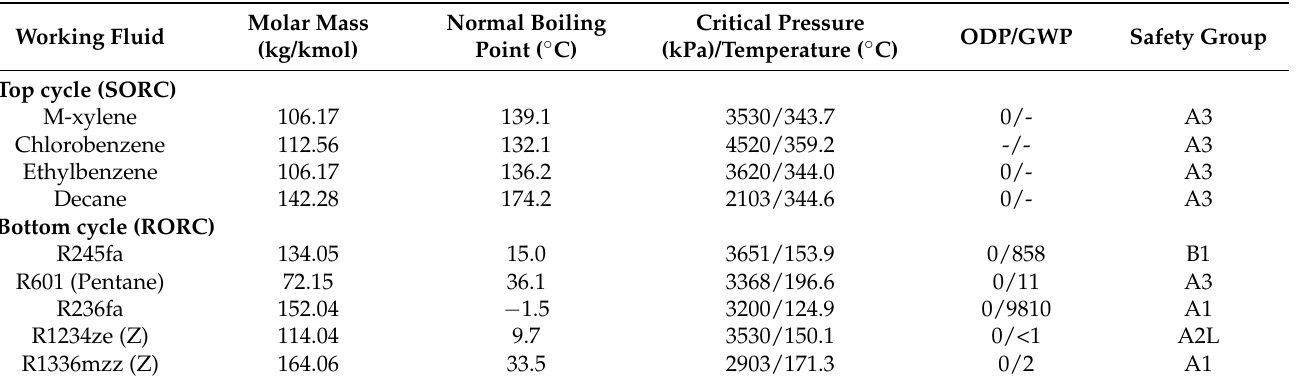
Table 2. Working fluids properties